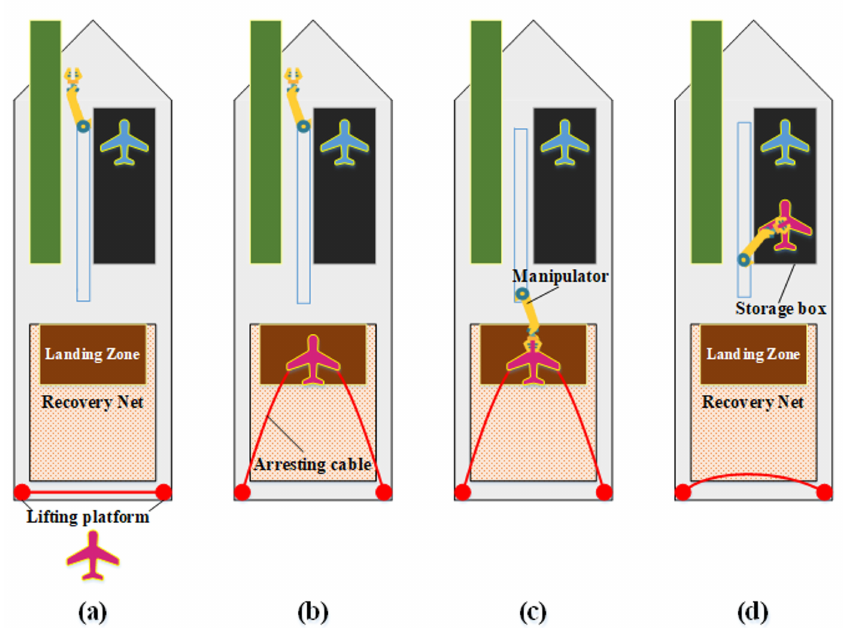
Figure 3. Main process of fully autonomous recovery of small ship-based fixed-wing UAV. ( a ) UAV and arresting cable coordinate attitude adjustment; ( b ) UAV tail-hook hooks the arresting cable; ( c ) UAV speed drops rapidly, and it lands on the recovery net; ( d ) the manipulator removes the drone from the arresting cable and recovery net and places it in a storage